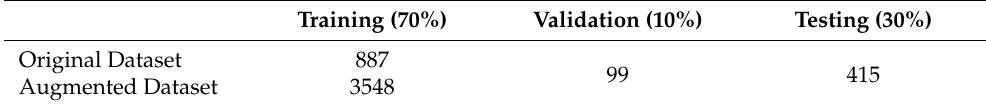
Figure 2. Generating the reference ground-truth (GT) and aliased MR images using the fully and under-sampled k -space data, respectively. Table 1. MCOR data Algorithm 1 Dataset preparation for parallel imaging simulation.